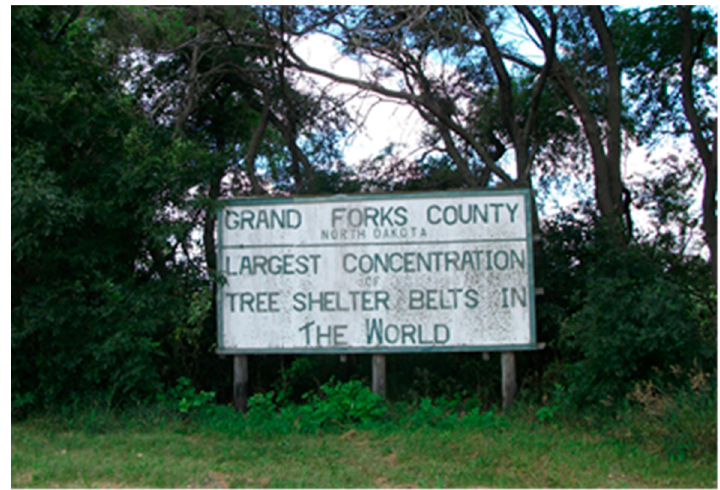
Figure 1. A roadside sign near Larimore, ND.